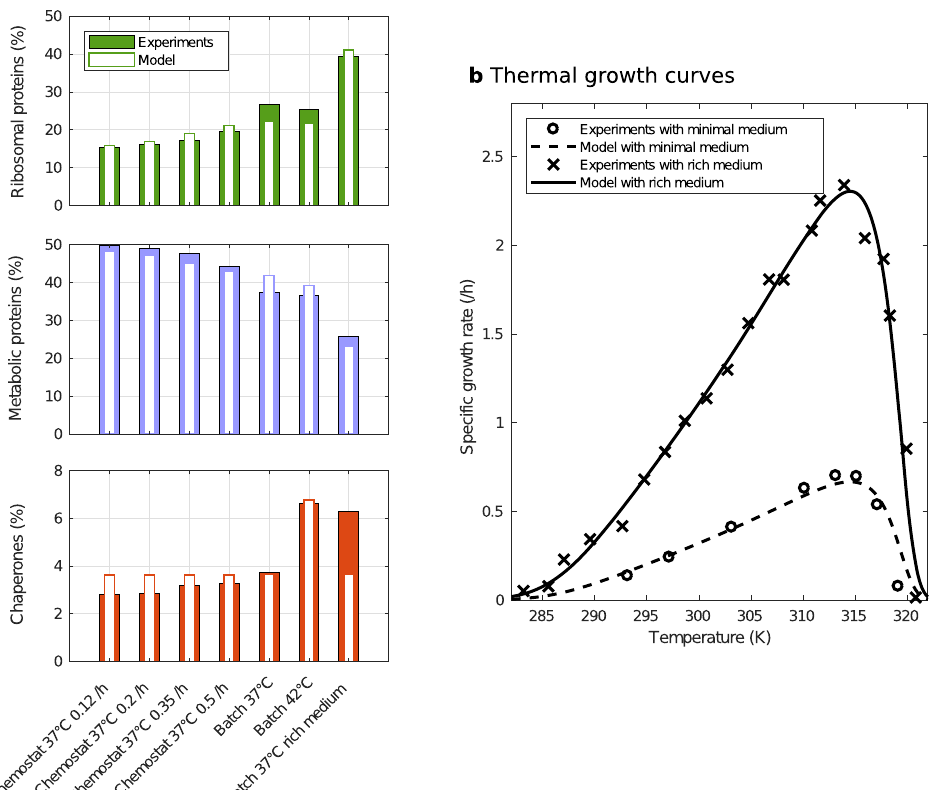
Fig. 2 Calibration of the coarse-grained resource allocation model with experimental data for E. coli . a Proteome allocation to different sectors in % of total protein mass for seven conditions, namely growth in chemostat at 37 o C (dilution rates of 0.12/h, 0.2/h, 0.35/h, and 0.5/h), and in batch (exponential phase) at 37 o C and 42 o C in glucose minimal medium, and at 37 o C in rich medium (data from ref. 25 ). b Speci fi c growth rate as a function of temperature in glucose minimal and rich media (data from refs. 26,27 ,